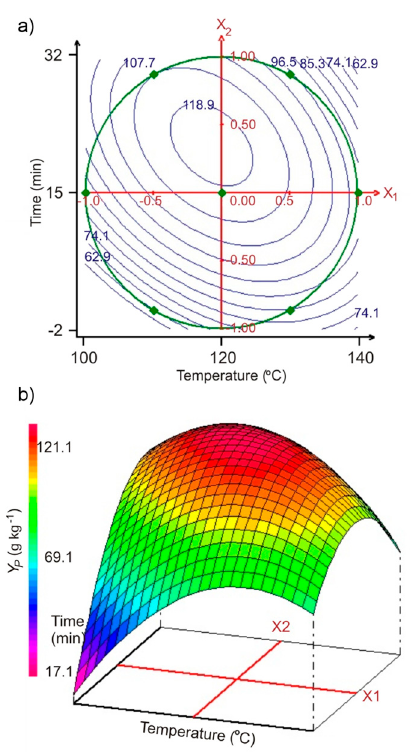
Figure 1. ( a ) Contour plots of pectin yield Y P versus extraction temperature and time of SBP hydrothermal treatment (representations based on the quadratic polynomial model, Equation 1; results obtained from Doehlert matrix, Table 2); ( b ) corresponding three-dimensional plot.